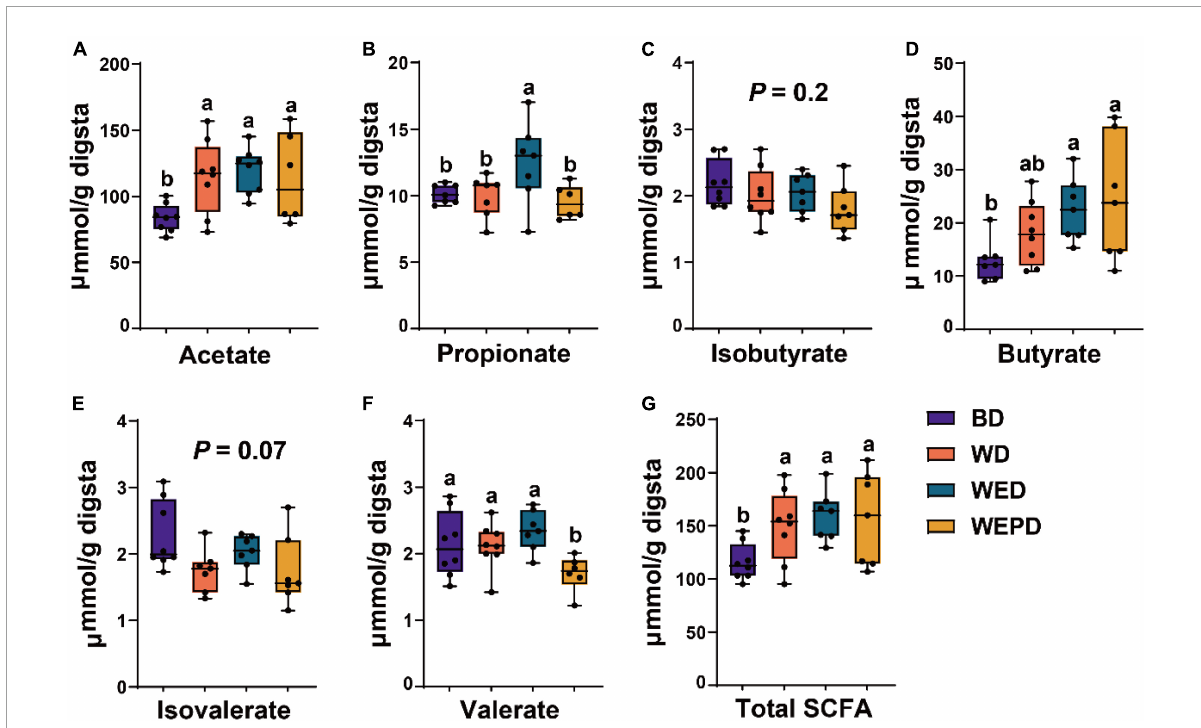
FIGURE5 Concentrations of short-chain fatty acids. Difference of acetate (A) , propionate (B) , isobutyrate (C) , butyrate (D) , isovalerate (E) , valerate (F) , and total SCFA (G) among four diet treatments. Different letters (a, b) means significant differences ( P <